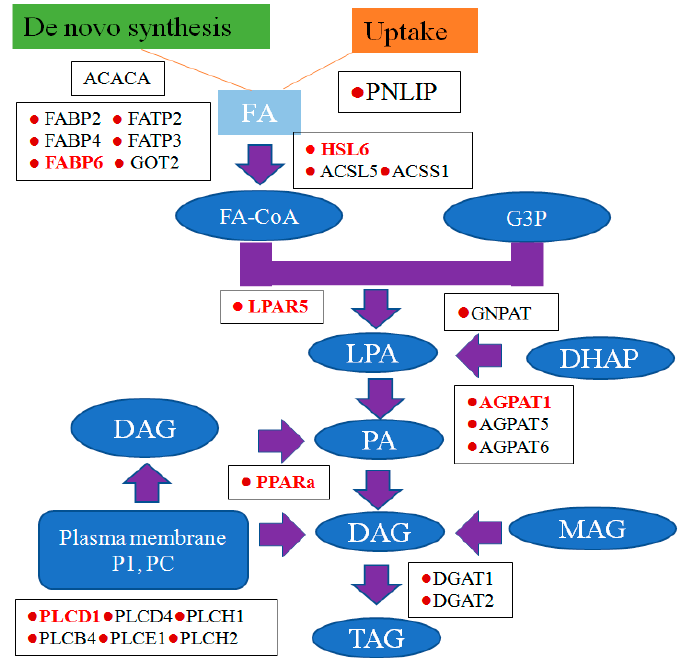
Figure 5. Genes involved in triacylglycerol synthesis.